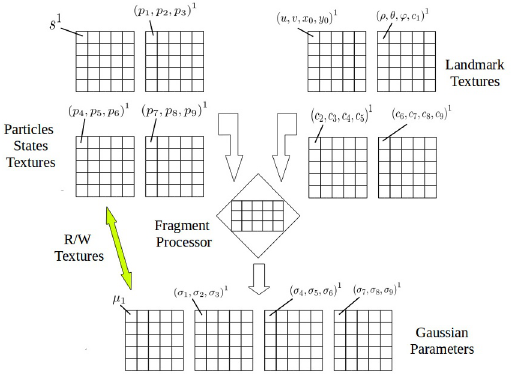
Figure 1. The matched landmark parameters, particle state and the computed Gaussian relative to the first particle (id = 1),